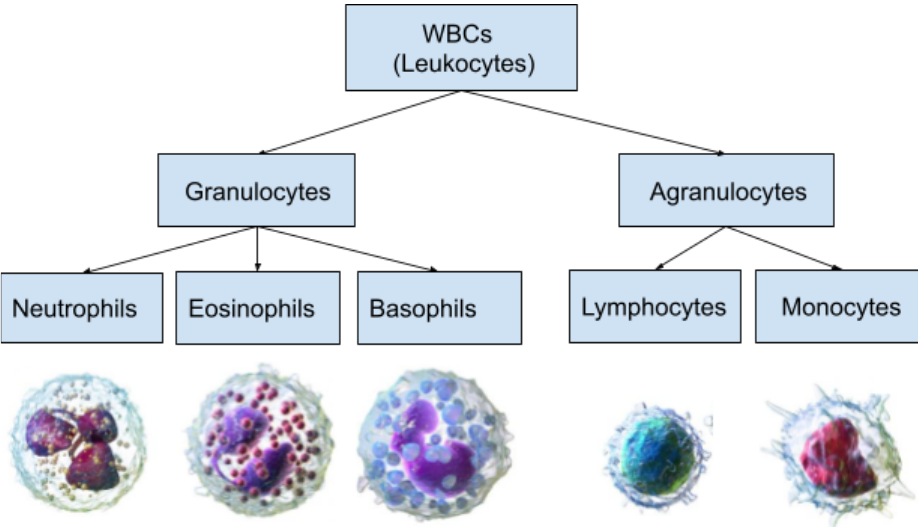
Figure 1. White blood cell